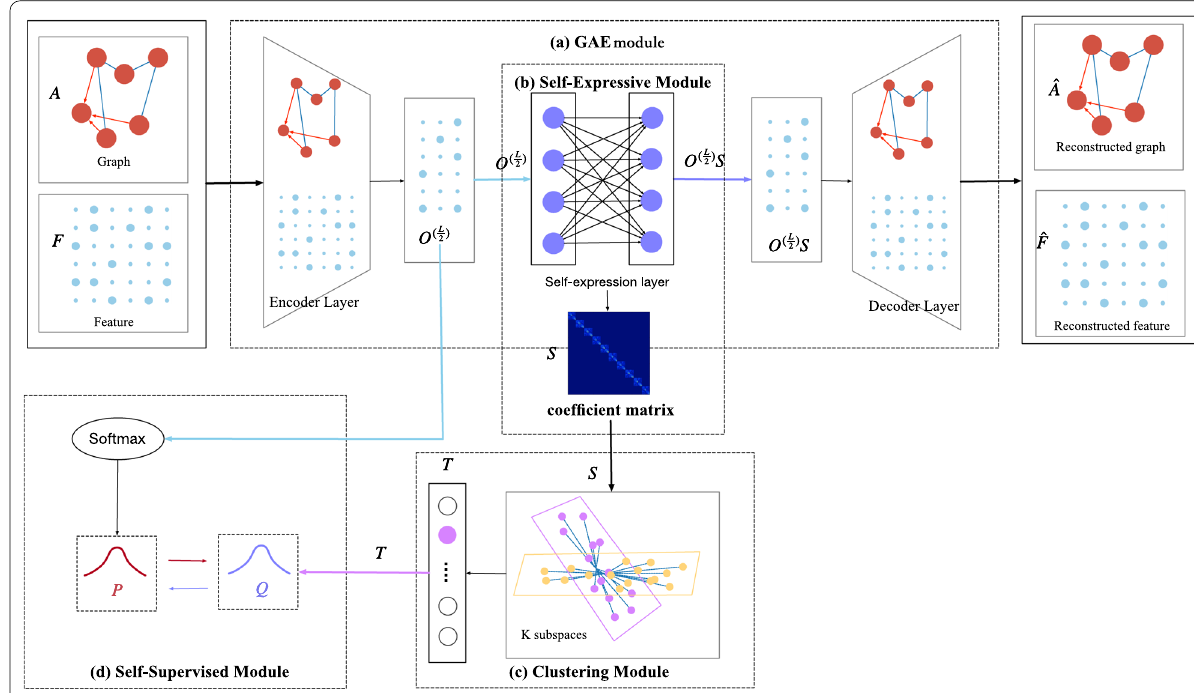
Fig. 1 The framework of the proposed